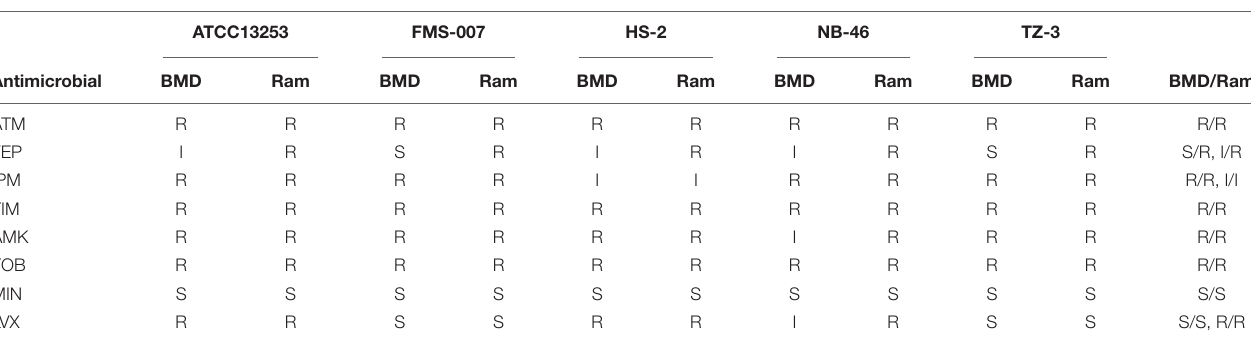
FIGURE 2 | The relative metabolic rate of the five Elizabethkingia spp. strains determined by Raman-DIP. The antimicrobial concentrations of group SD, ID, and RD were obtained from the M100 guidelines (CLSI, 2019). SD, susceptible breakpoint corresponds to antimicrobial concentration; ID, intermediate breakpoint corresponds to antimicrobial concentration; RD, resistant breakpoint corresponds to antimicrobial concentration; ATM, aztreonam; FEP, cefepime; IPM, imipenem; TIM, ticarcillin/clavulanic acid; AMK, amikacin; TOB, tobramycin; MIN, minocycline; and LVX, levofloxacin. TIM was composed of two intermediate breakpoints (the data of lower concentration of intermediate breakpoints was shown). TABLE 2 | The AST of five Elizabethkingia spp.